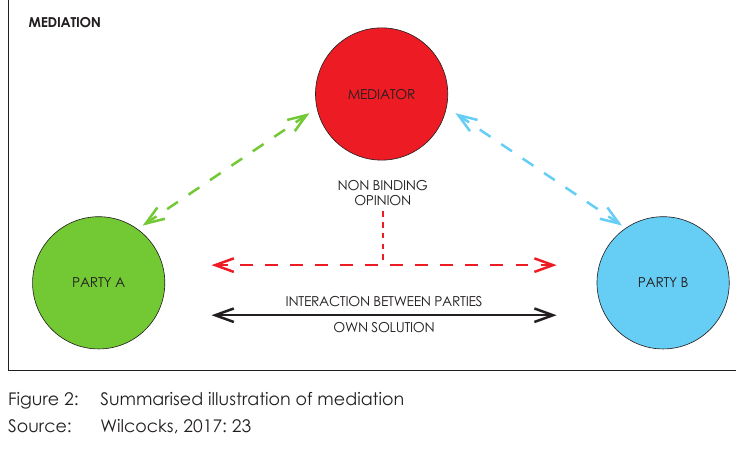
Figure 2: Summarised illustration of